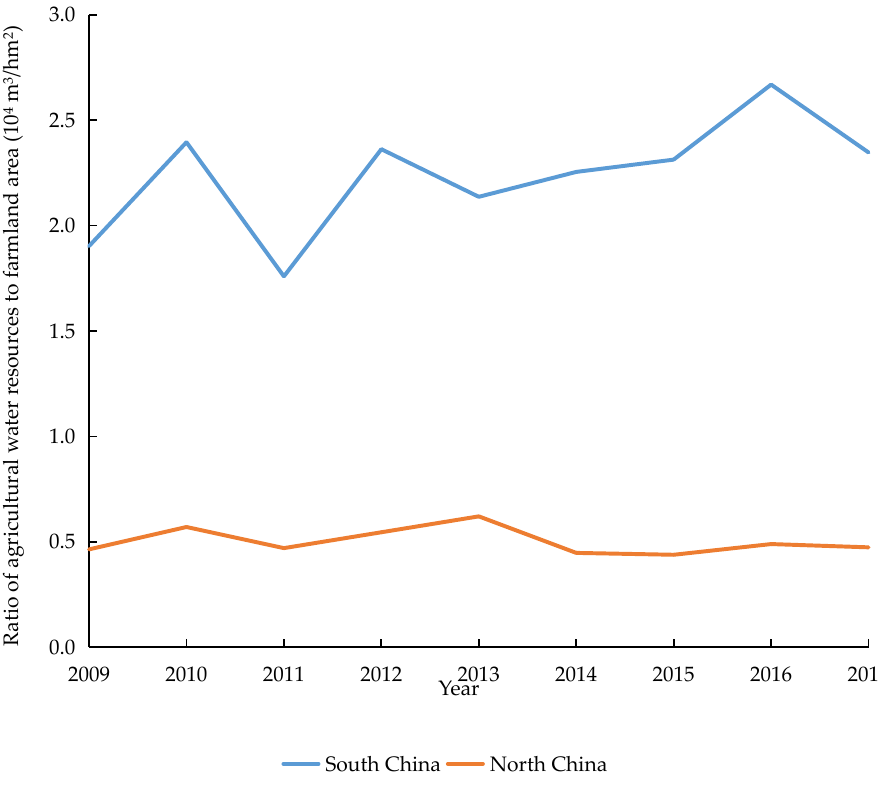
Figure 5. Changes in the ratios of agricultural water resources to farmland area in South and North China from 2009 to 2017. Notes: The total water resources, total water consumption, agricultural water consumption and farmland area data are used to calculate the ratios of agricultural water resources to farmland area [51].